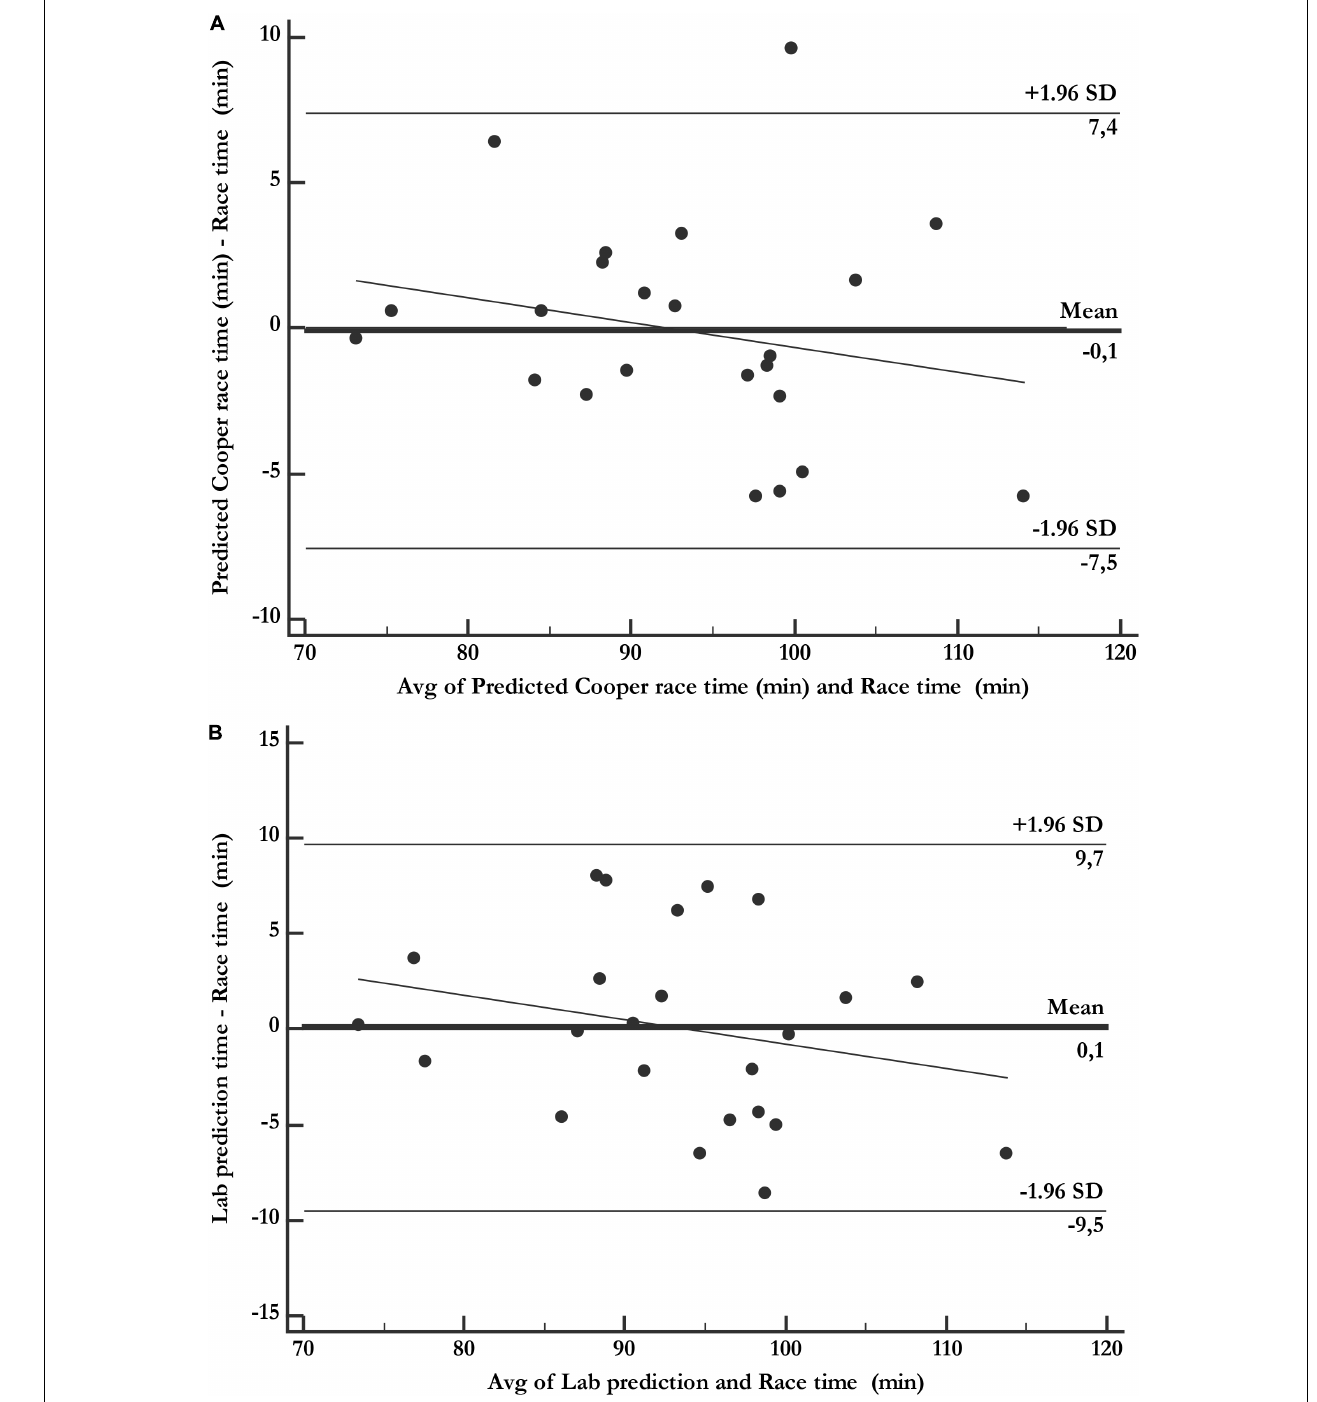
FIGURE 2 | Bland-Altman plots comparing predicted time with actual race time. (A) Cooper test. (B) Laboratory test.